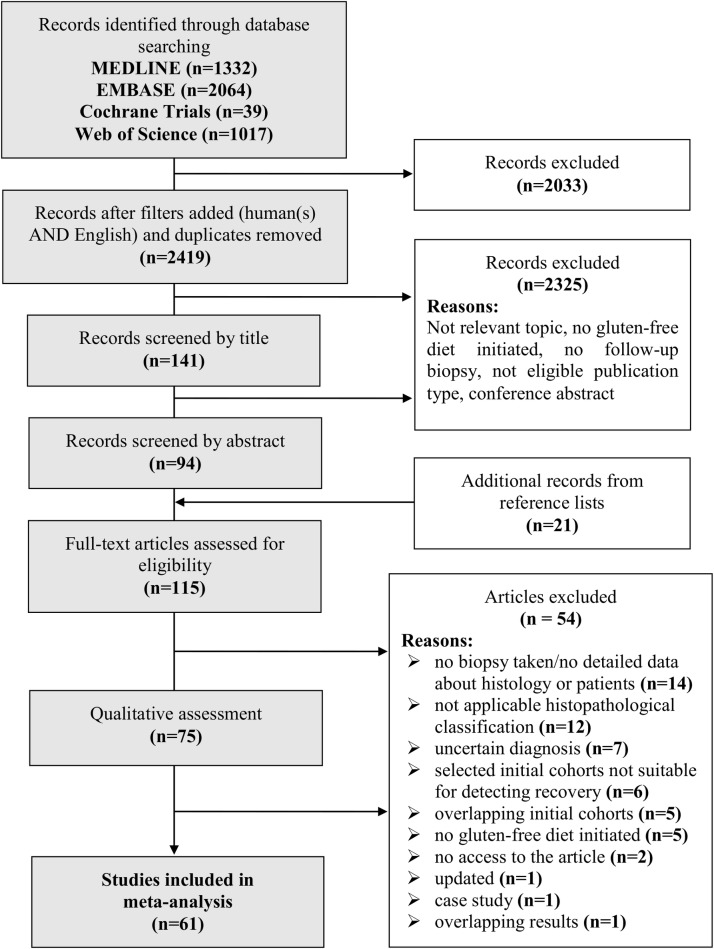
Flow chart of assessment of studies identified in the meta-analysis.